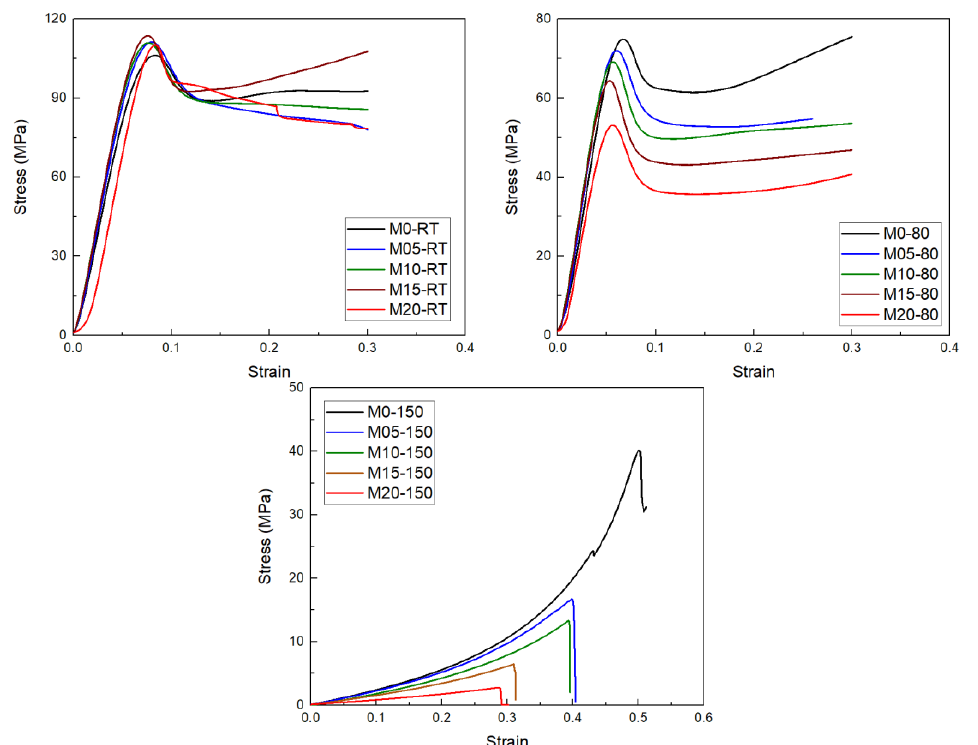
Figure 5. Stress-strain curves of phenolic modified epoxy.